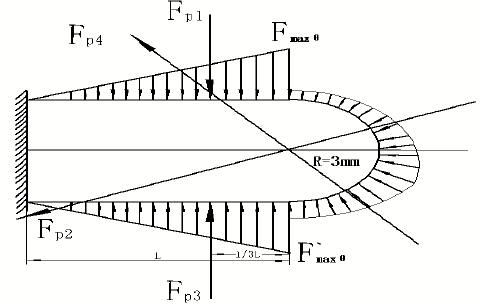
Figure A3. Cantilever beam load distribution of slide